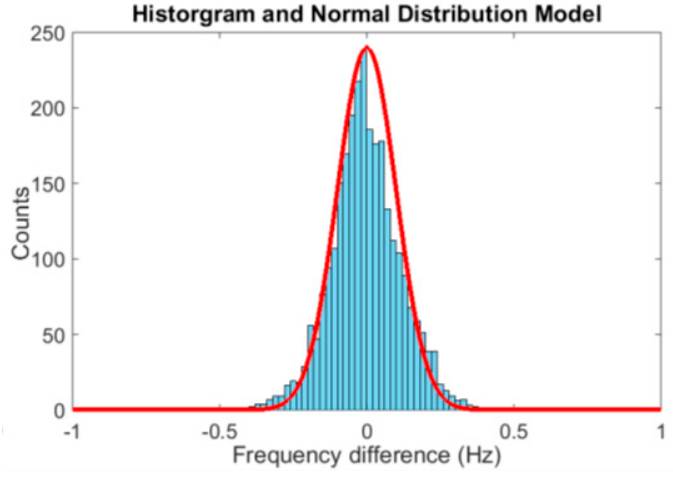
Figure 5. The histogram of average HR frequency variance calculated in adjacent 4s windows